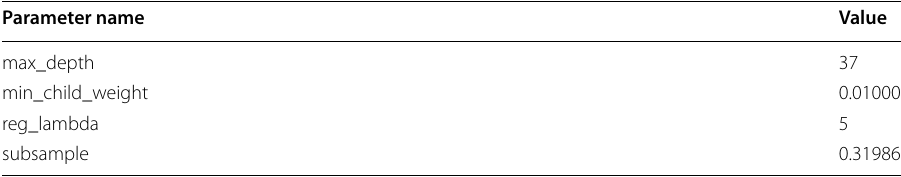
Parameter values for classifier yielding best results in terms of AUPRC